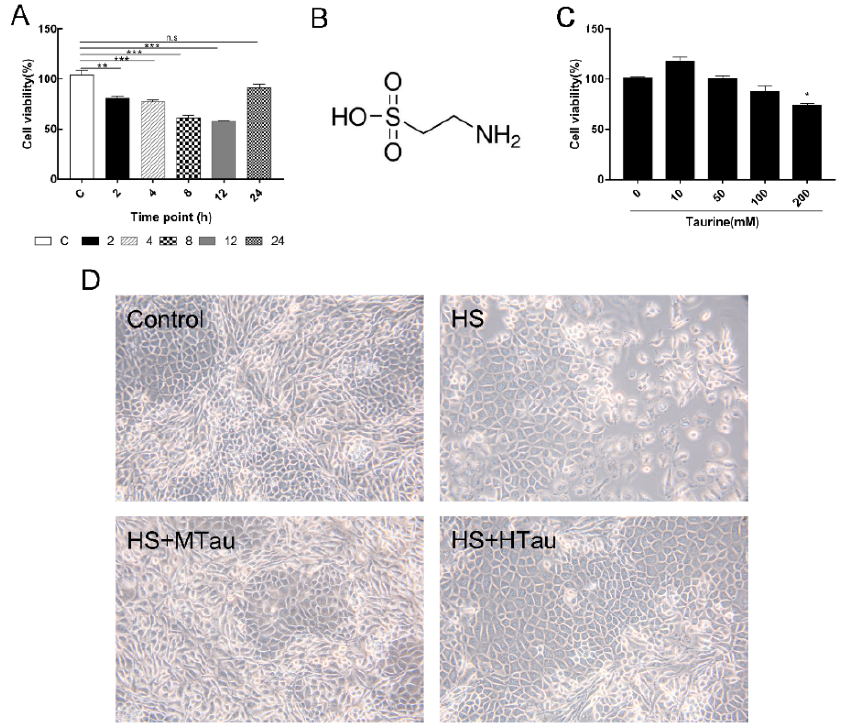
Figure 1. Effects of taurine supplementation on the cell viability and cell morphology of mammary alveolar cells ‐ large T antigen (MAC ‐ T) cells. ( A ) cell viability induced by heat shock on MAC ‐ T cells, ( B ) chemical structure of taurine, ( C ) cell viability when treated with different concentrations of taurine for two hour and then recovered for another 12 h, and ( D ) phase ‐ contrast micrographs of MAC ‐ T cells were exposed to heat stress with and without taurine. Magnification 200×. * p < 0.05, ** p < 0.01, and *** p < 0.001.